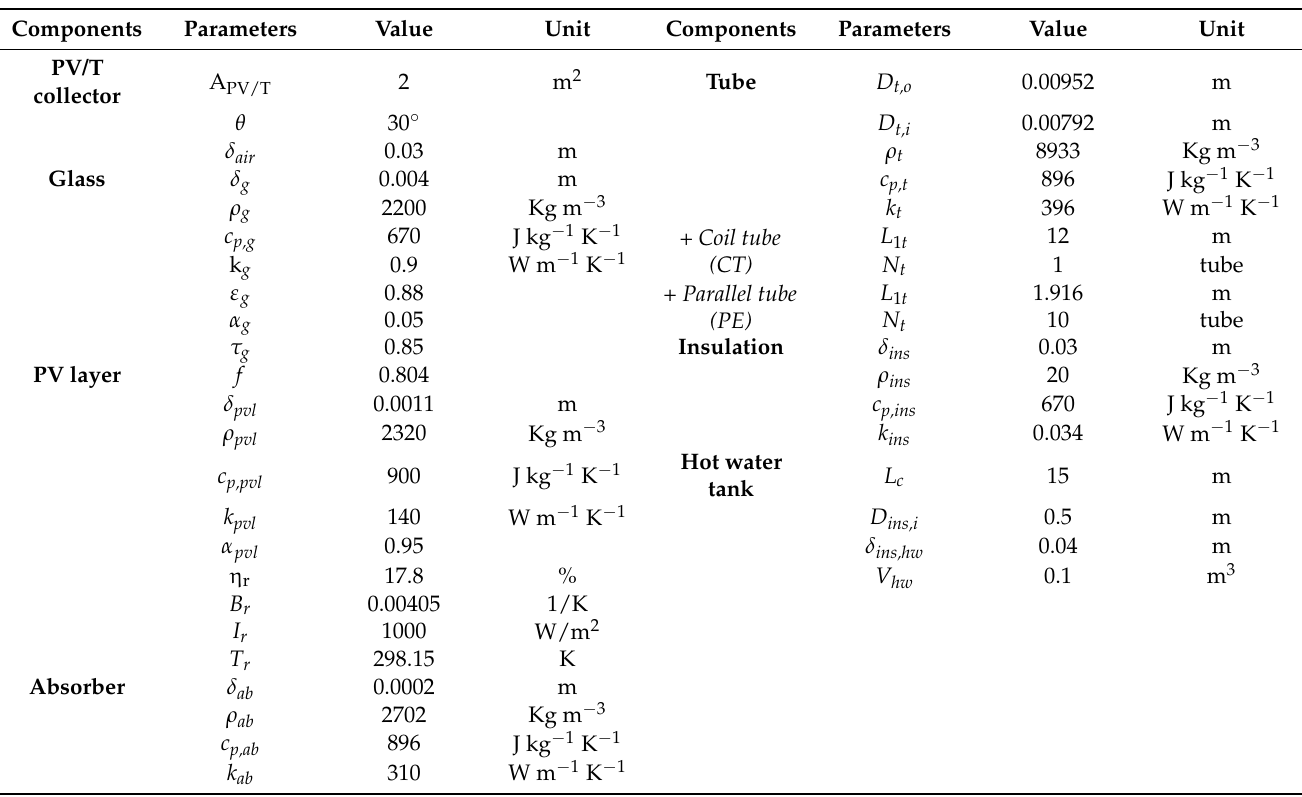
Table 1. Parameters used in the simulation program